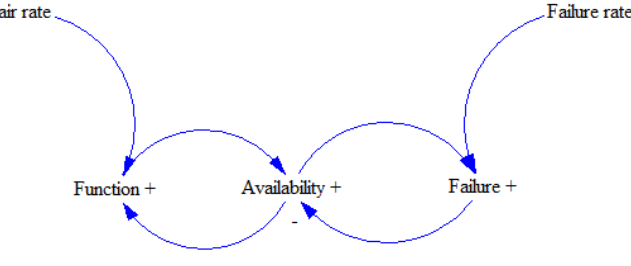
Figure 3. Casual loop diagram of availability.